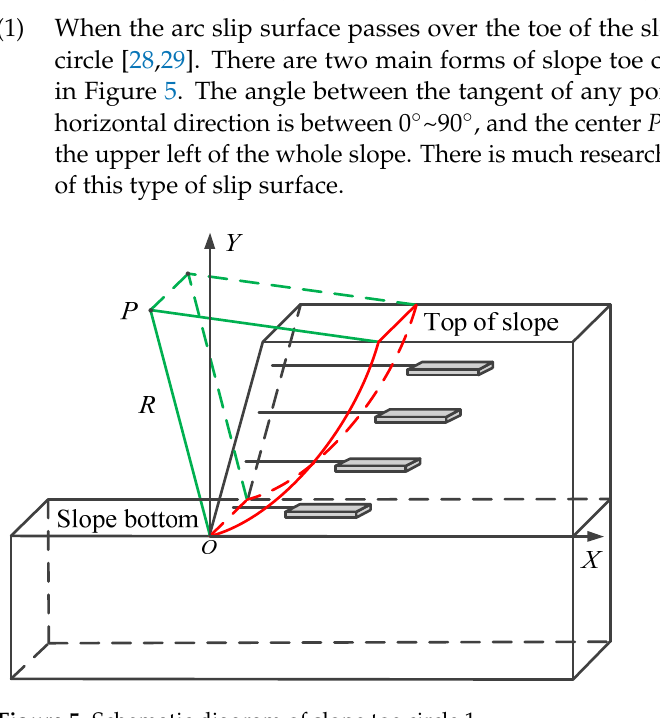
Figure 5. Schematic diagram of slope toe circle 1.